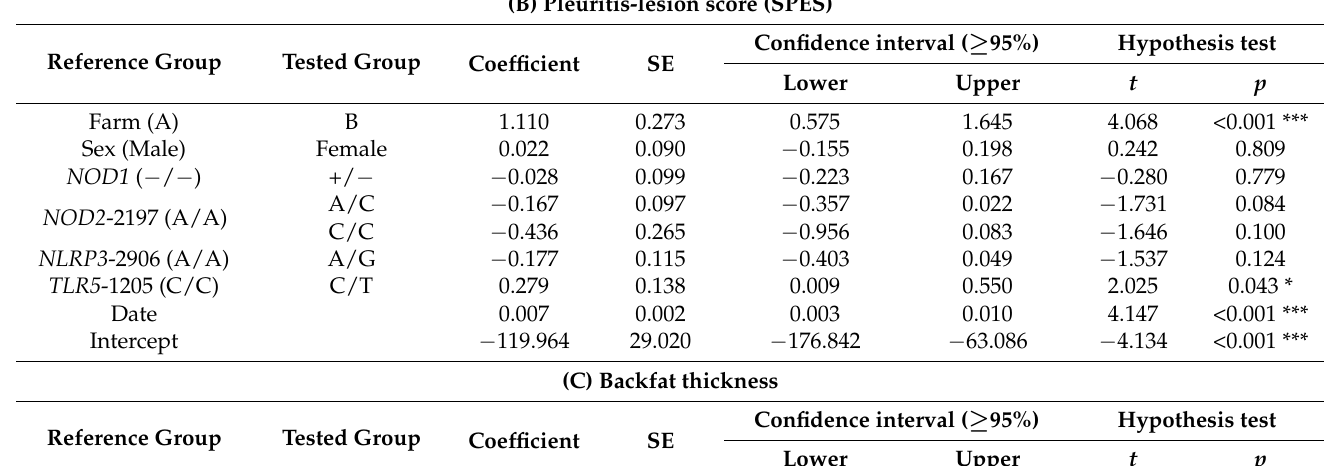
Table 5. Cont. (B) Pleuritis-lesion score